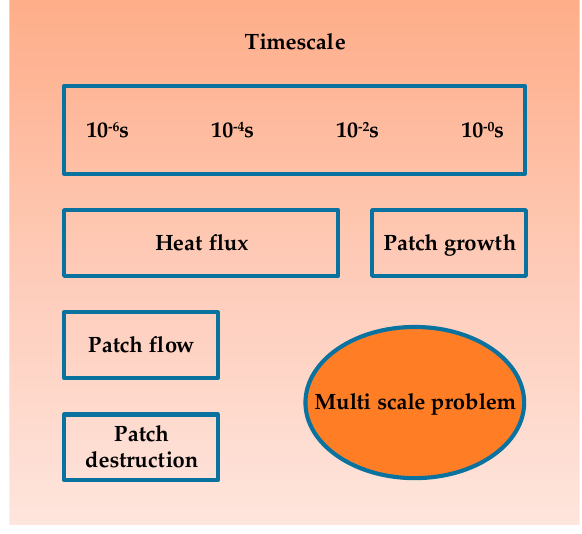
Figure 8. Characteristic times for the multi-scale problem in analysis [56].